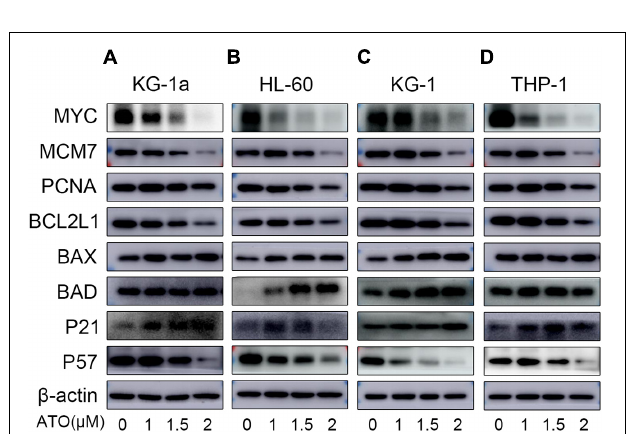
FIGURE 5 | Validation of the RNA sequencing with WB. Validation of the data with WB in four different AML cells (KG-1a, HL-60, KG-1, and THP-1 cells). The representative proteins relative to the DEGs in the DNA replication, cell apoptosis, or cell cycle pathways were examined by Western blotting in KG-1a cells (A) , HL-60 cells (B) , KG-1 cells (C) , and THP-1 cells (D)